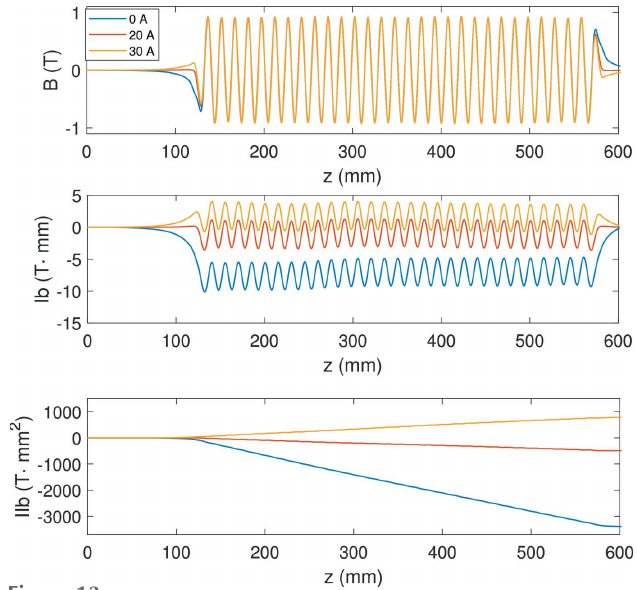
Figure 13 Hall probe measured magnetic field map (top) and the corresponding first field integrals (middle) and the second field integrals (bottom) with 400 A main current and 0 A, 20 A, 30 A correction